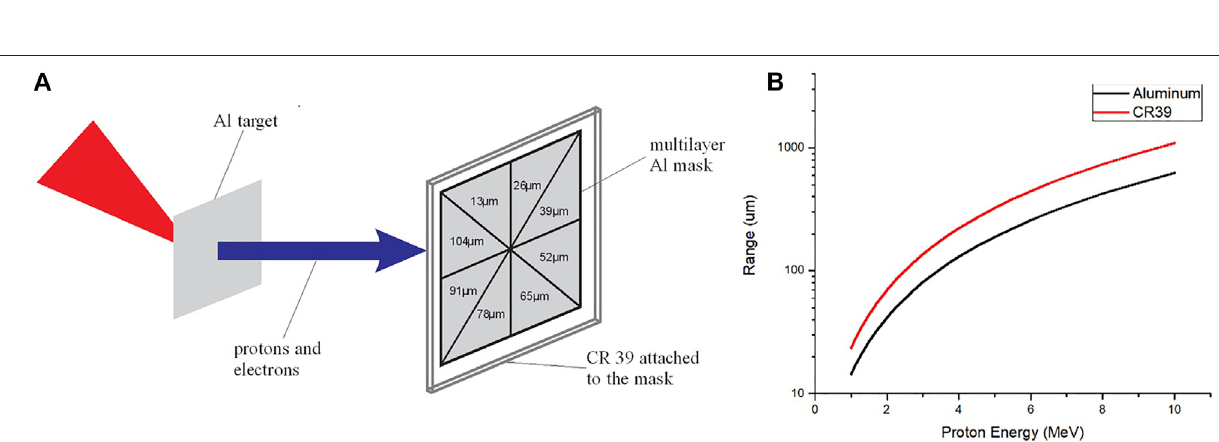
Frontiers in Physics |